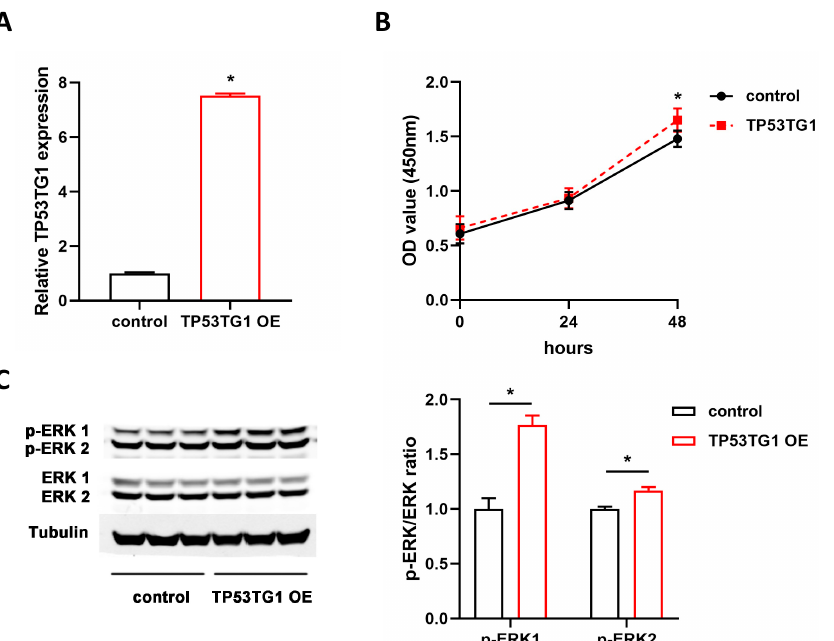
Figure 6. Overexpression of TP53TG1 increases cell proliferation and ERK activation in HepG2. ( A – C ) The RNA expression level of TP53TG1 (normalized to 18S), n = 3 ( A ), proliferation rate, error bars represent SD, n = 6 ( B ), and protein expression level of p-ERK1/p-ERK2 and ERK1/ERK2 (left) as well as qualification (right) ( C ) in HepG2 cells transfected with control or TP53TG1 overexpression adenovirus. The protein expression levels of p-ERK1 and p-ERK2 were normalized to ERK1 and EKR2, respectively. * p < 0.05.